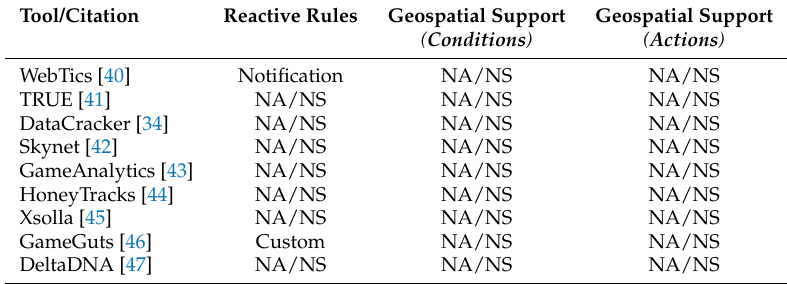
Table 6. Comparison of reaction related features among academic and commercial tools for game analytics. NA/NS = Not Applicable, Not Specified or